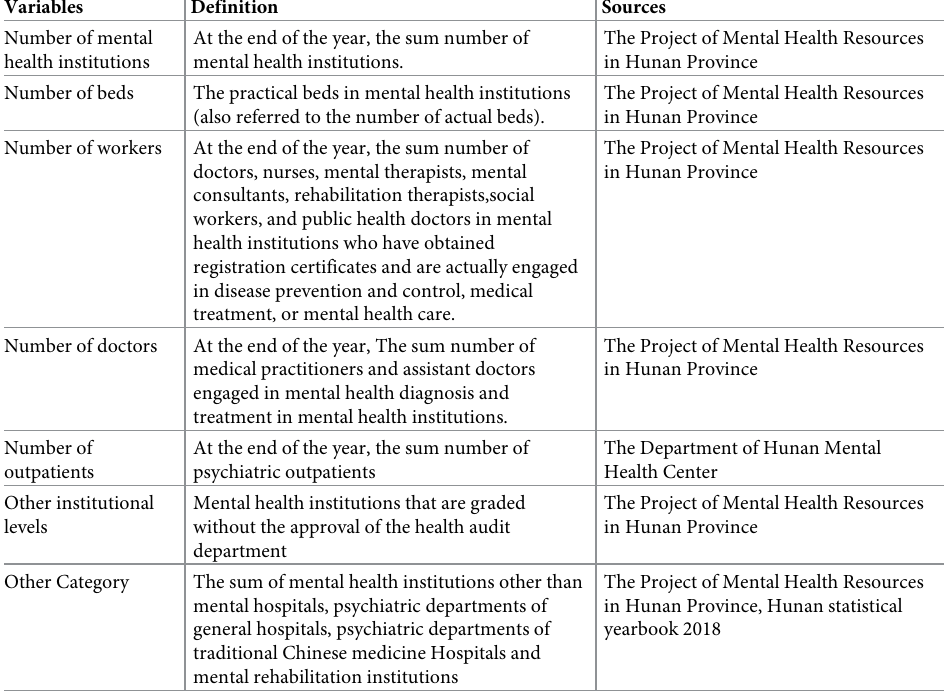
Table 1. Definition of equity indicators.